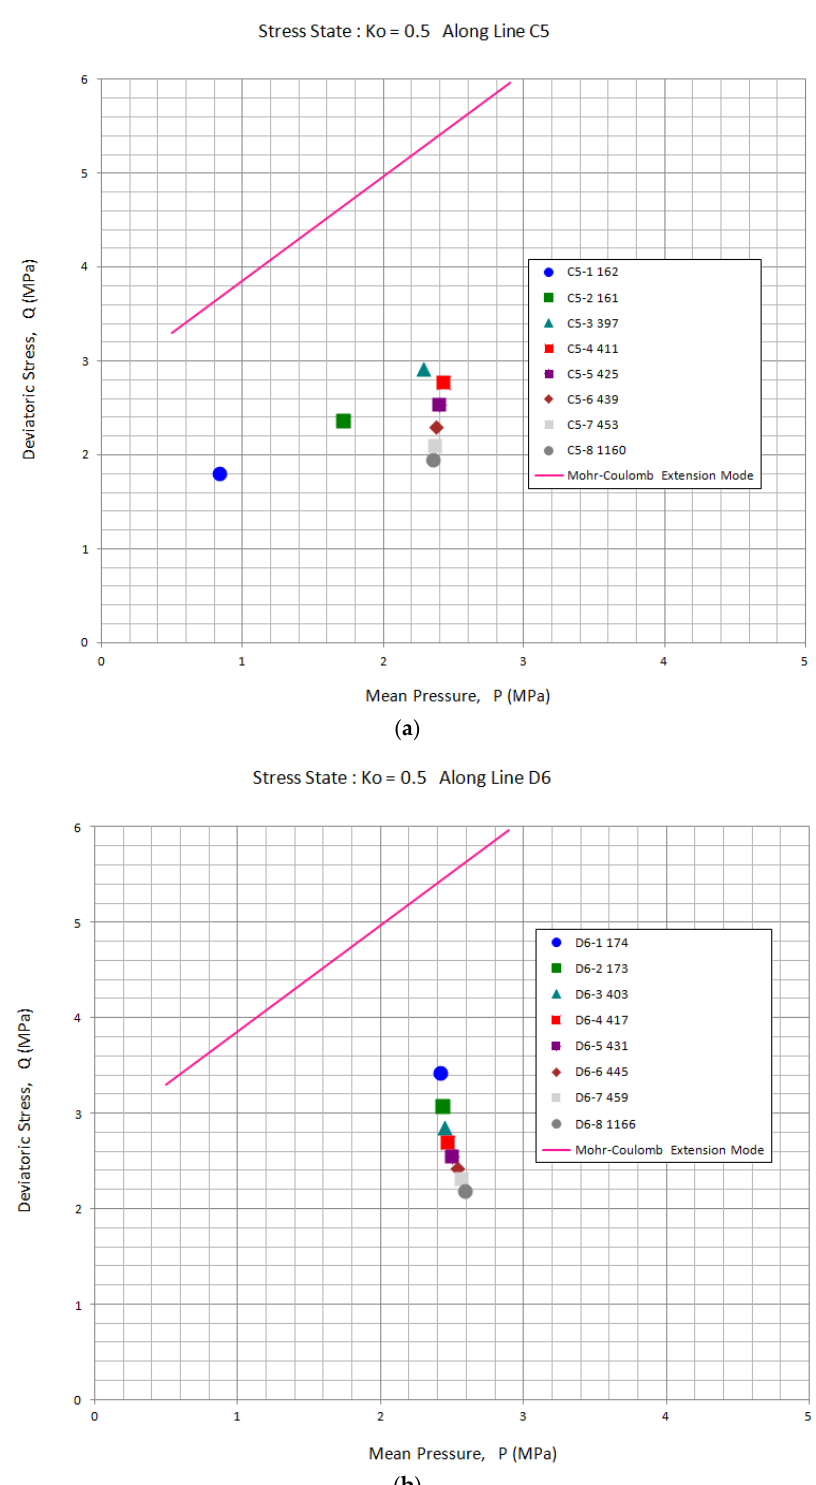
Figure 12 . Stress state (Ko = 0.5): ( a ) Line C5; ( b ) Line D6. Figure 12. Stress state (Ko = 0.5): ( a ) Line C5; ( b ) Line